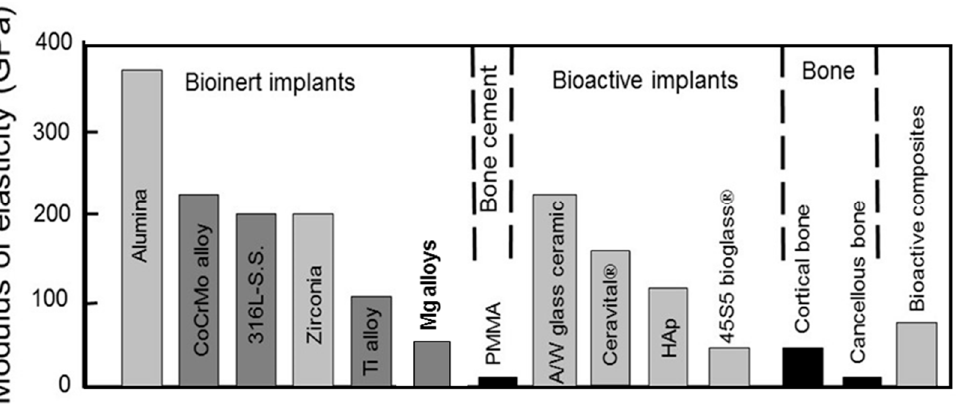
Figure 2. Moduli of elasticity of prosthetic biomaterials in comparison to cortical and cancellous bone. Light grey: ceramics, dark grey: metals, black: polymers. Light grey: ceramics, dark grey: metals, black: